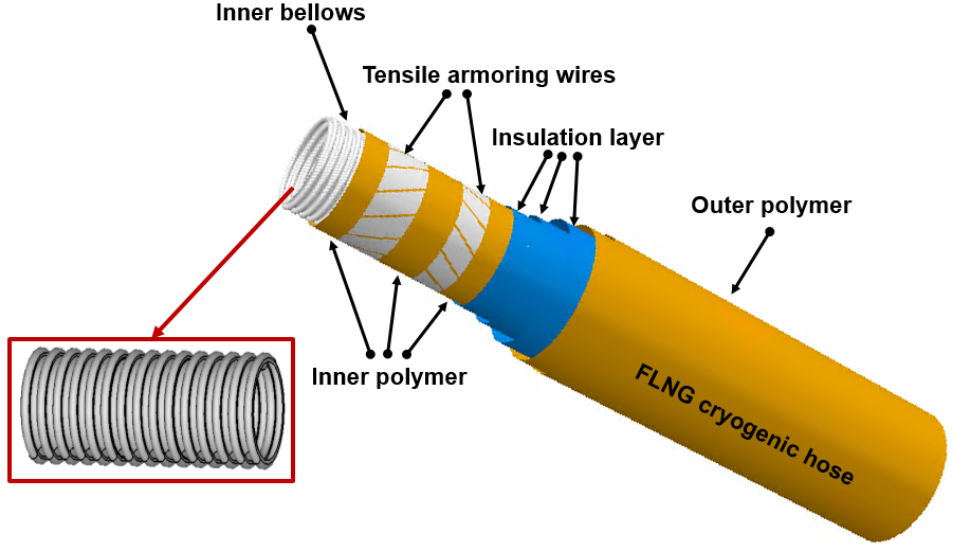
Figure 1. Typical structure of a FLNG cryogenic hose and bellows.